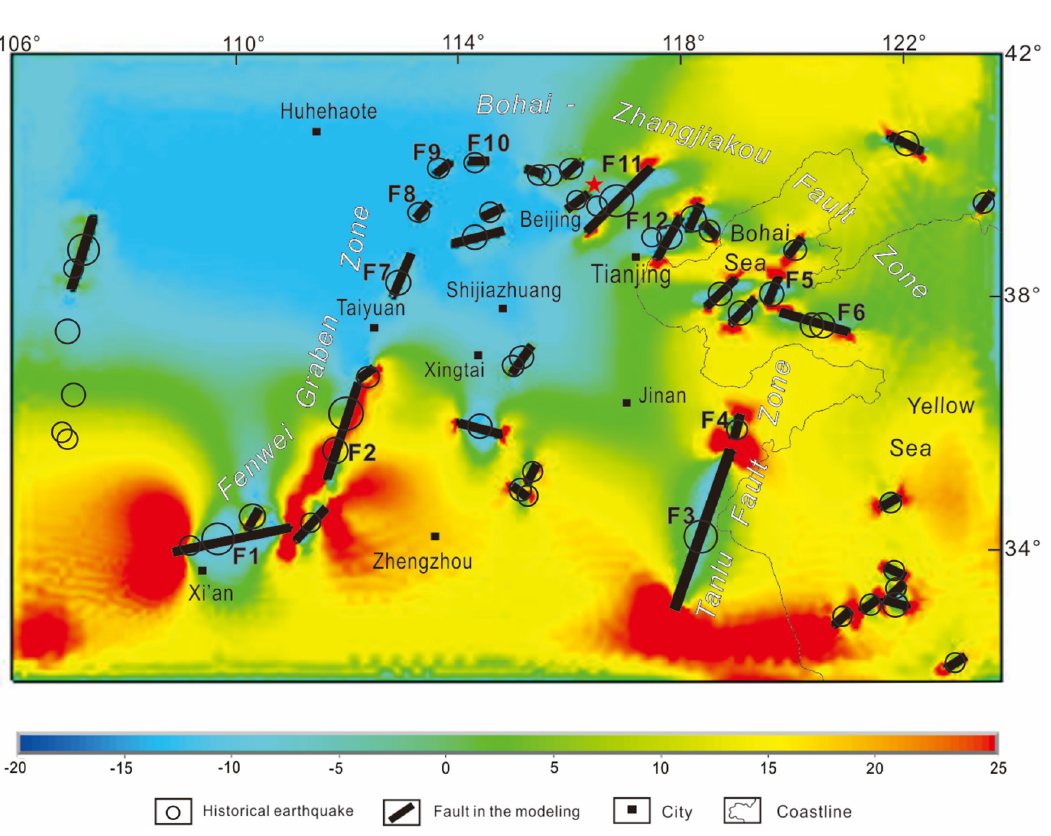
Fig 5. Maximum principal strain strain values calculated by the model and historical earthquakes in the CNCB. Black lines denote the seismogenic faults. An approximately N-S-trending extension is located in the southeast part of the research area, while an approximately N-S-trending shortening is located in the northwest